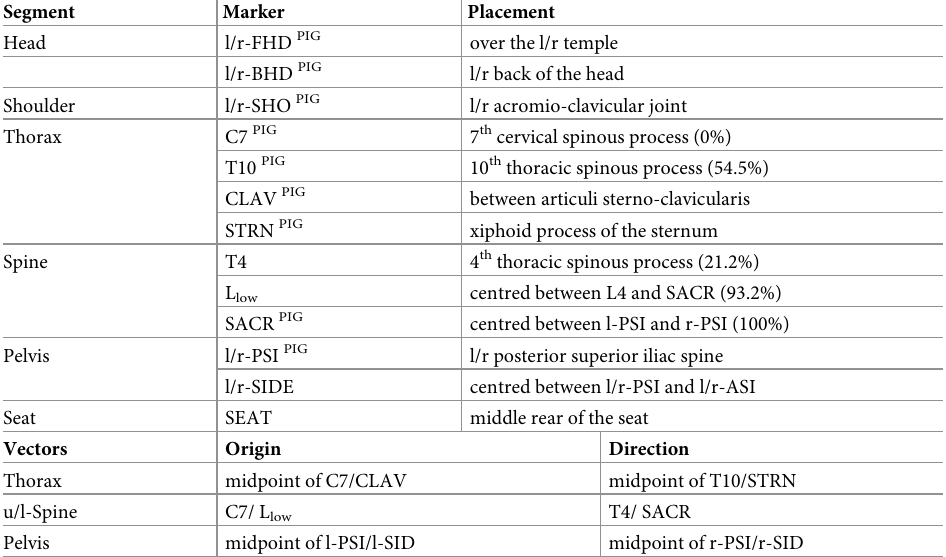
Table 1. Marker placement. Segment Marker Placement Head l/r-FHD PIG over the l/r temple l/r-BHD PIG l/r-SHO PIG